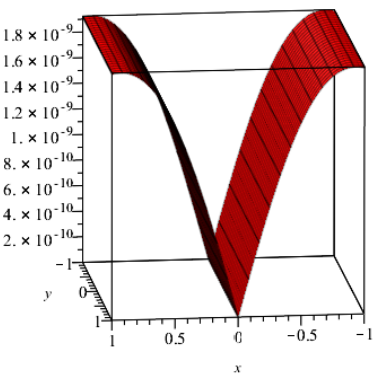
Figure 8. Behavior of the absolute error of problem at integer-order problem